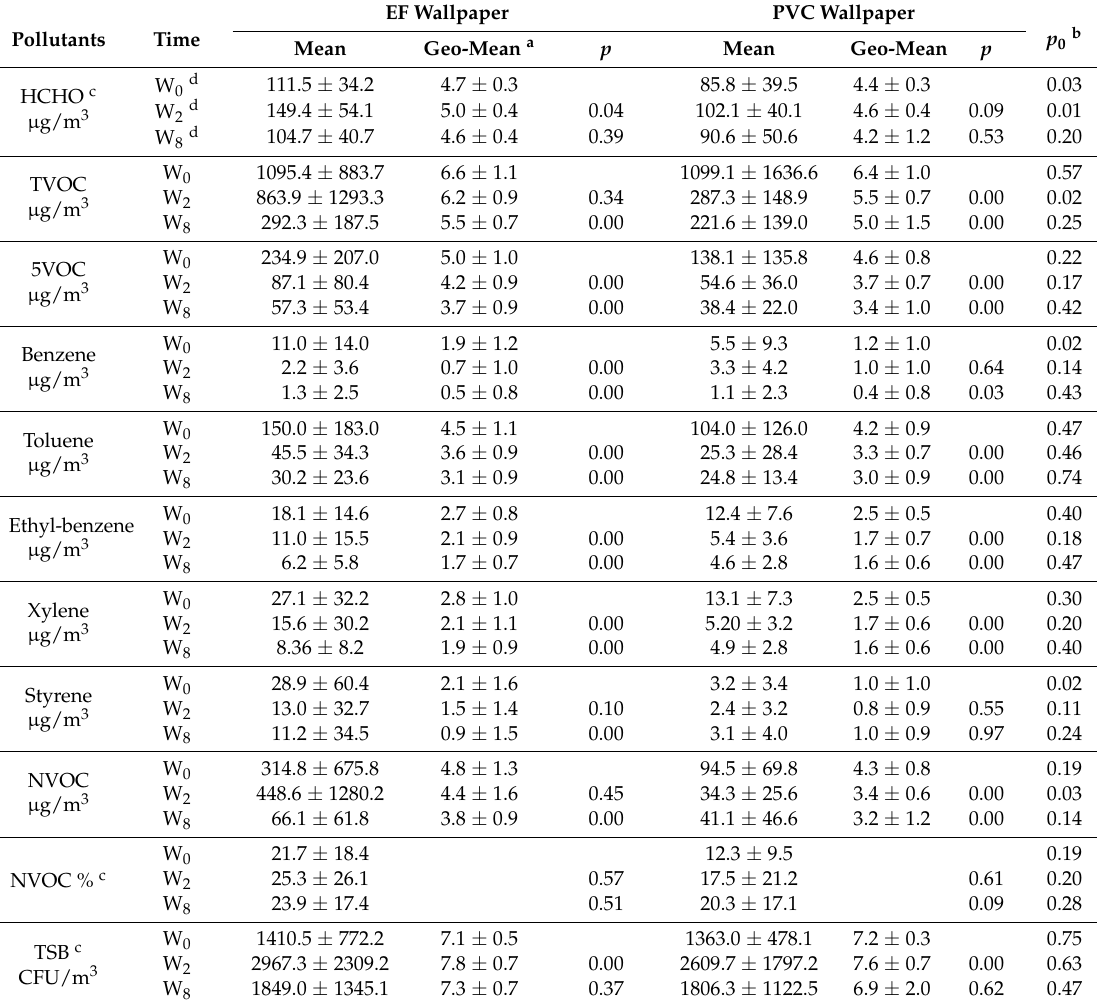
Table 5. Indoor air pollutants before and after